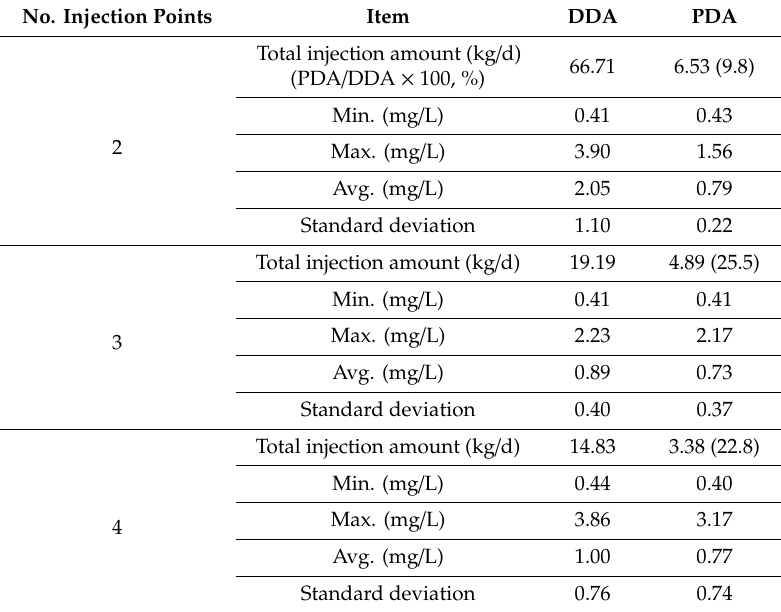
Table 5. Water-quality results of DDA and PDA under abnormal